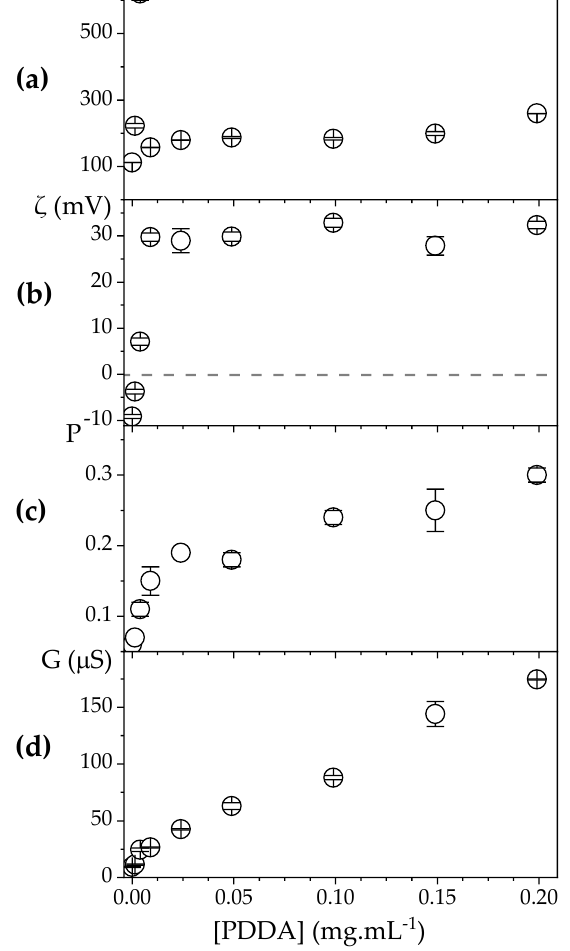
Figure 3. E ff ect of PDDA concentration on: ( a ) hydrodynamic diameter (Dz); ( b ) zeta potential ( ζ ); Figure 3. Effect of PDDA concentration on: (a) hydrodynamic diameter (Dz); (b) zeta potential (ζ); (c) ( c ) polydispersity (P); ( d ) conductance (G) of PDDA / OVA NPs at [OVA] = 0.1 mg. mL − 1 . The dashed polydispersity (P); (d) conductance (G) of PDDA/OVA NPs at [OVA] = 0.1 mg. mL −1 . The dashed line line indicates zeta-potential ( ζ ) = 0 occurring around [PDDA] = 0.004 mg · mL − 1 indicates zeta-potential (ζ) = 0 occurring around [PDDA] = 0.004 mg·mL −1 .